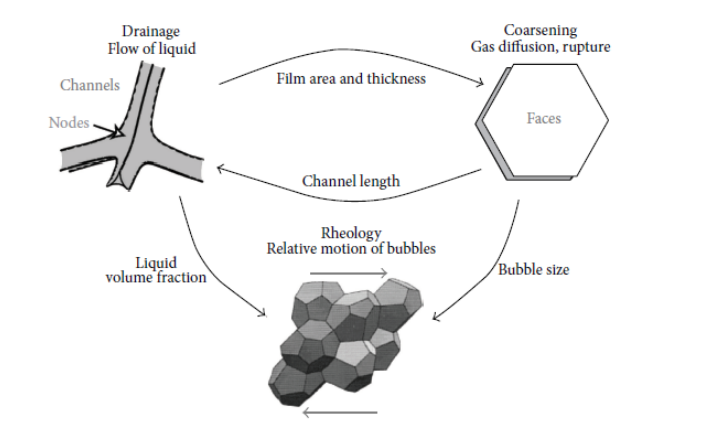
Figure 1. Demonstration of drainage, coarsening, and rheology of the